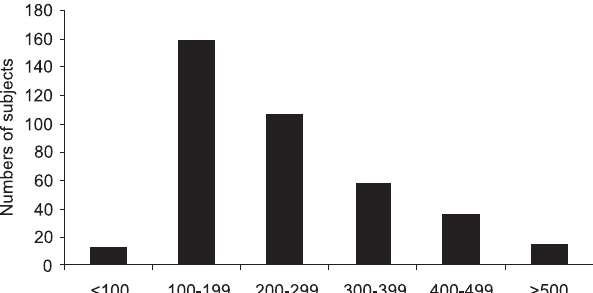
Figure 3 - Distribution of iodine concentration in the studied population. The median urinary excretion was 210 µg/L. Note that one-third of the subjects had an excessive iodine excretion (>300